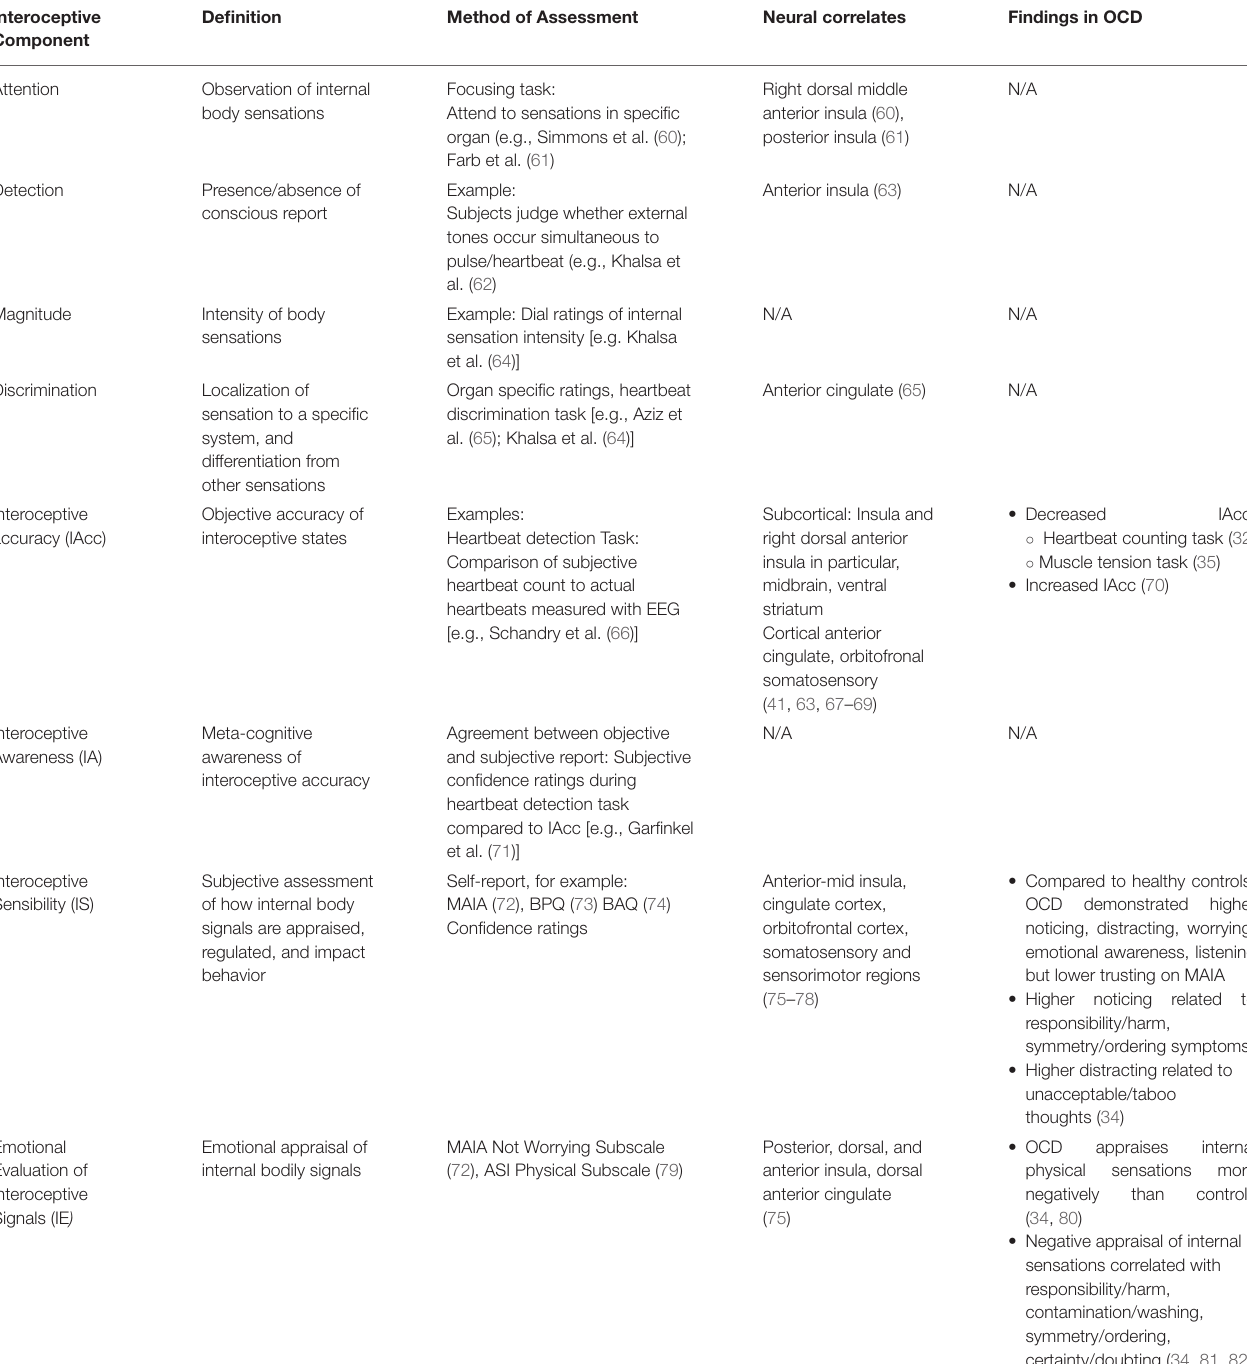
TABLE 1 | Interoceptive